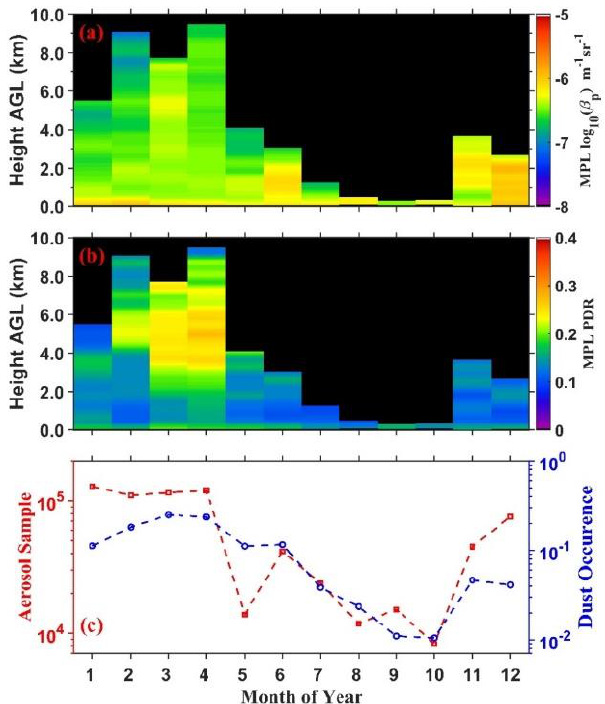
Figure 4. The climatological month–altitude sections of dust aerosols ( a ) particular backscatter coefficients and ( b ) PDR, and ( c ) aerosol samples (red line) and dust occurrence (blue line) for cloud- free profiles from MPL at the NSA site from January 2013 to September 2017. The dust occurrence is defined as the ratio of dust aerosol samples and all aerosol samples. The samples are based on the data with 1 h and 30 m bin.